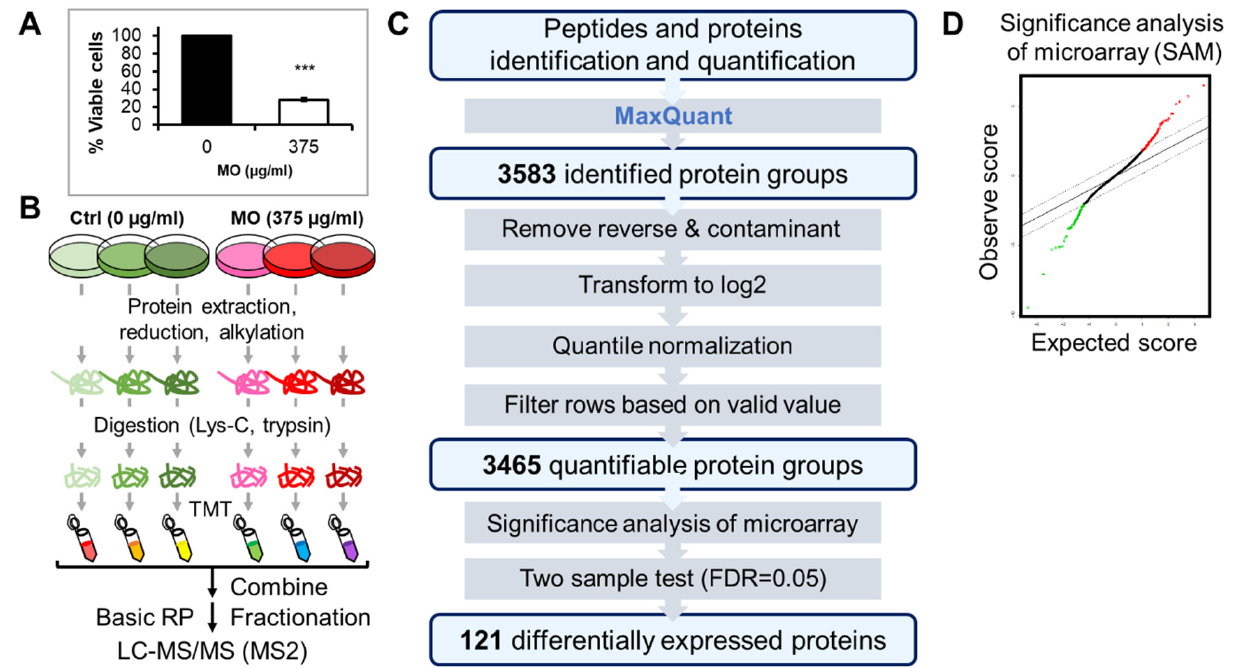
Figure 1. Quantitative proteomics analysis of MO treatment in HCT116 cell line. ( A ) Cell viability of HCT116 cells treated by MO for 48 h. *** p < 0.001. ( B ) Schematic representation of the workflow for TMT-based quantitative proteomics. ( C ) The analytical workflow of defining the differentially expressed proteins of MO treatment. ( D ) The quantile-quantile plot from 1000 permutations was plotted from the result of SAM on MO treatment with an FDR of 5%. Red dots indicate upregulated proteins, and green dots indicate downregulated proteins.